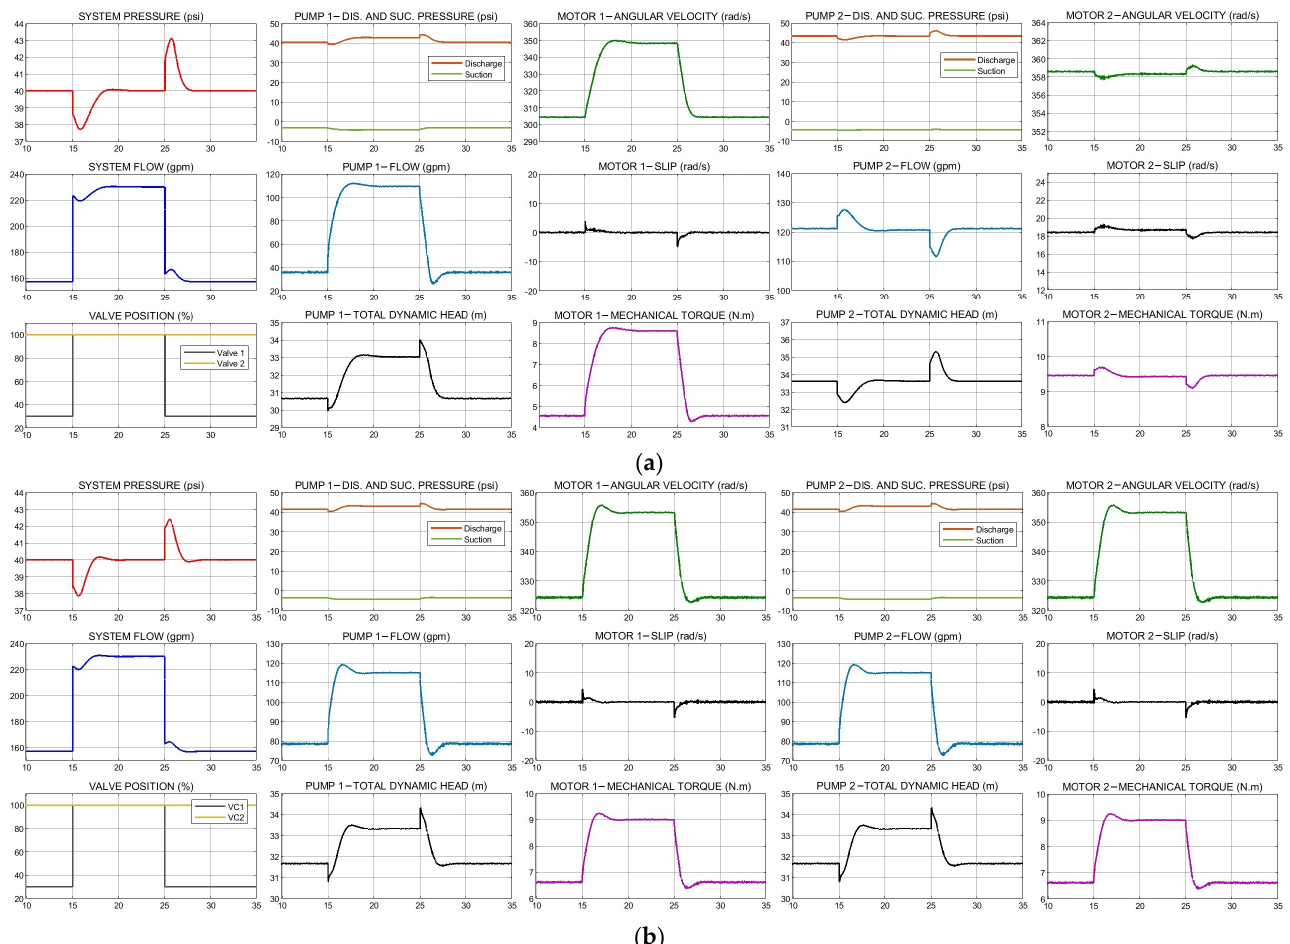
Figure 13. Dynamic response of the different hydraulic and mechanical variables of interest for a set point of 40 psi: ( a ) case study 1: a single pump at variable speed; ( b ) case study 2: both pumps at variable speed.